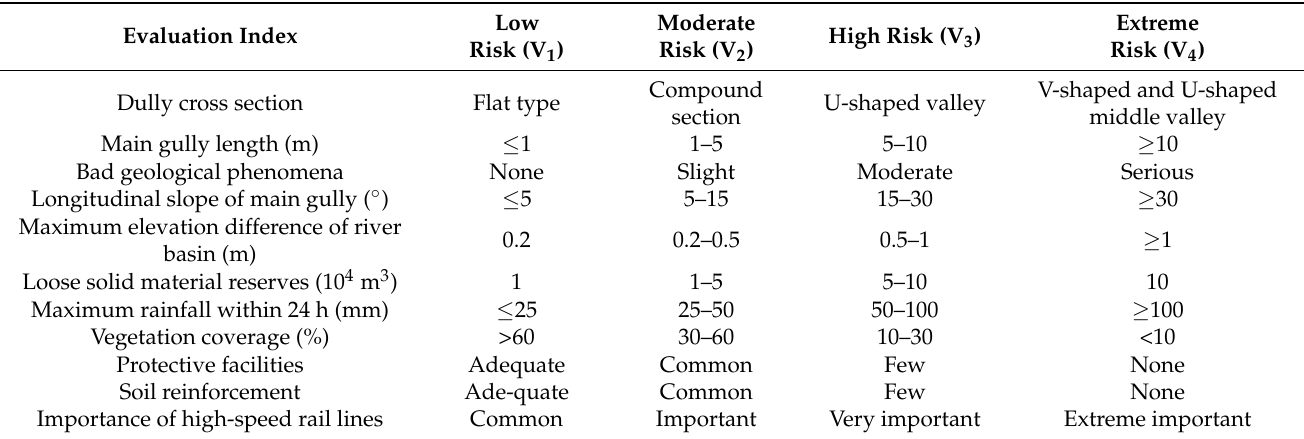
Table 2. Classification standard on evaluation index of debris flow risk.